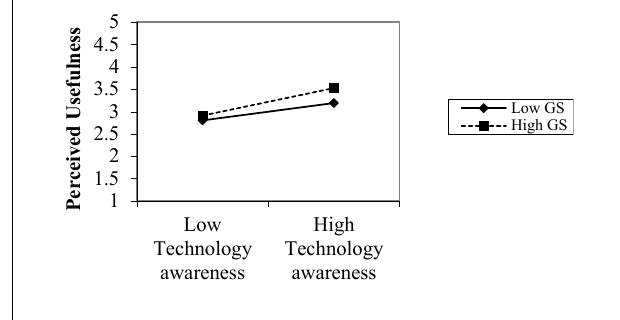
FIGURE 2 | Moderating role perceived usefulness. FIGURE 3 | Moderating role perceived ease of use.